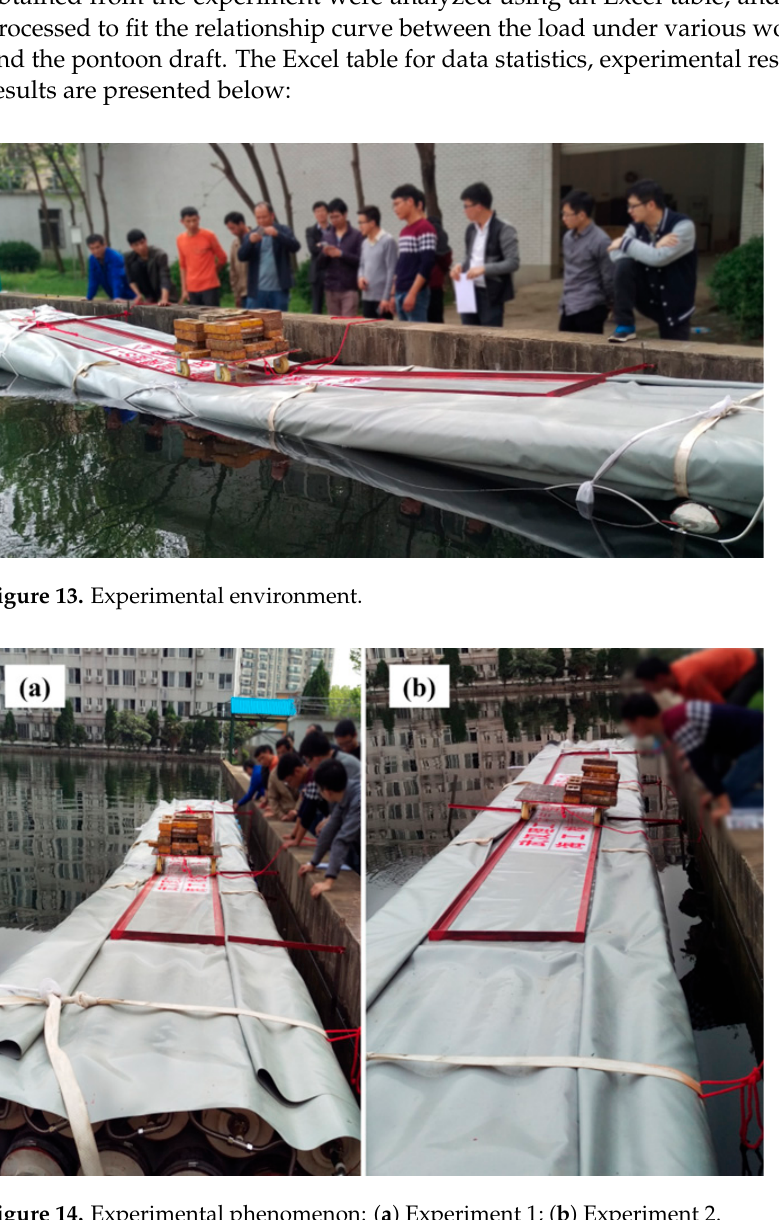
Figure 14. Experimental phenomenon: ( a ) Experiment 1; ( b ) Experiment